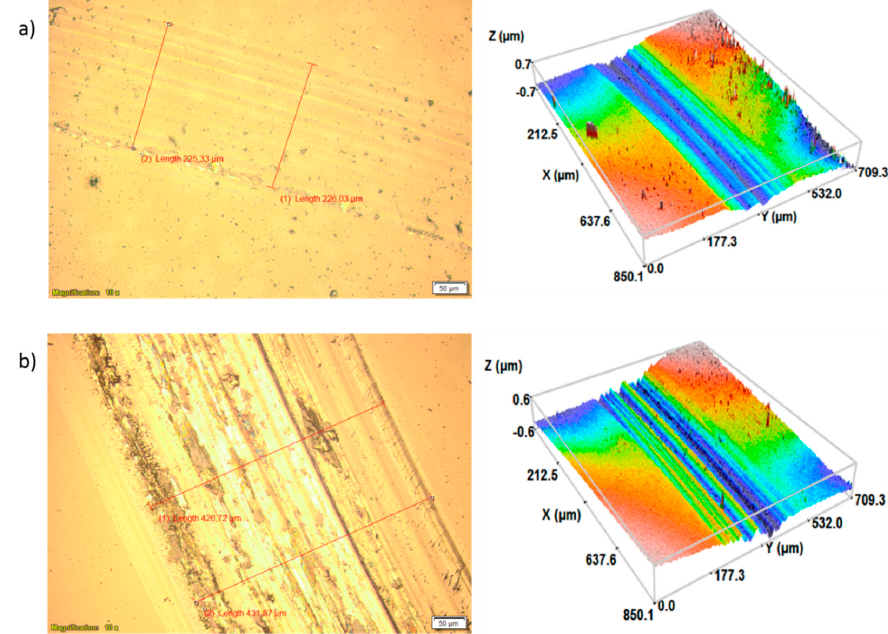
Figure 11. Aspects of the wear track obtained by optical and confocal microscopy after 20,000 cycles for the ta-C-coated sample ( a ) and for the WC:C-coated sample ( b ).